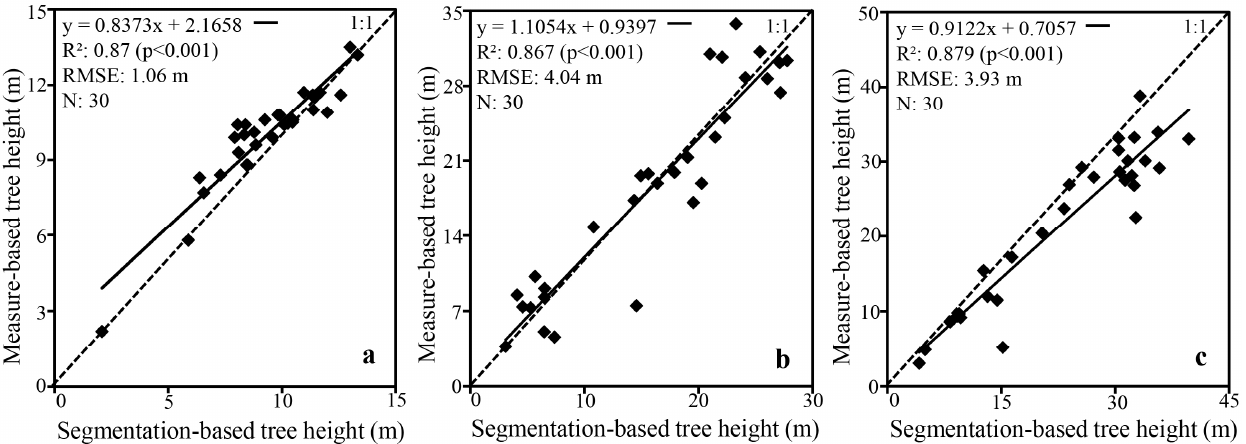
Figure 8. The regression relationship between the tree height extracted by tree segmentation and the measured tree height. ( a ) Douglas fir, ( b ) Red alder, and ( c ) Bigleaf maple.